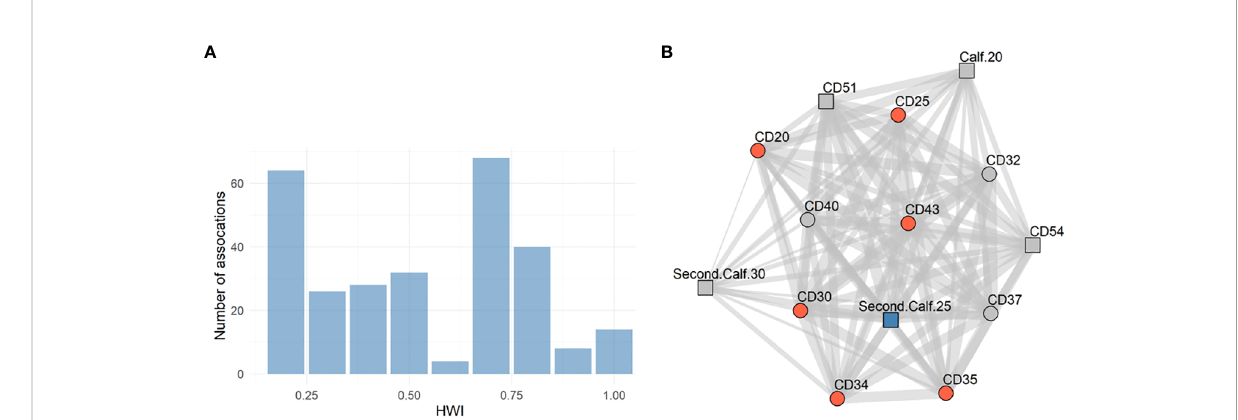
FIGURE 4 (A) Histogram of HWI values. HWI values higher than 0.1 for mature individuals (n = 25). (B) Social network of the common dolphins in 2021. The network structure of the local population in 2021 includes calves (n = 14). Red nodes represent females, blue represents a male, and grey represents individuals with unknown sex. Square nodes represent calves, and circles represent adults. The width of the edge represents the strength of the association between the dyad according to the HWI